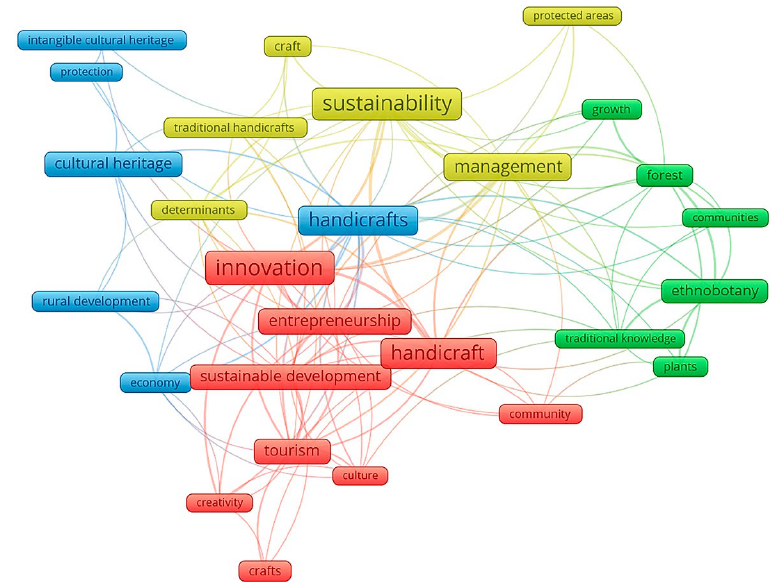
Figure 4. Clusters